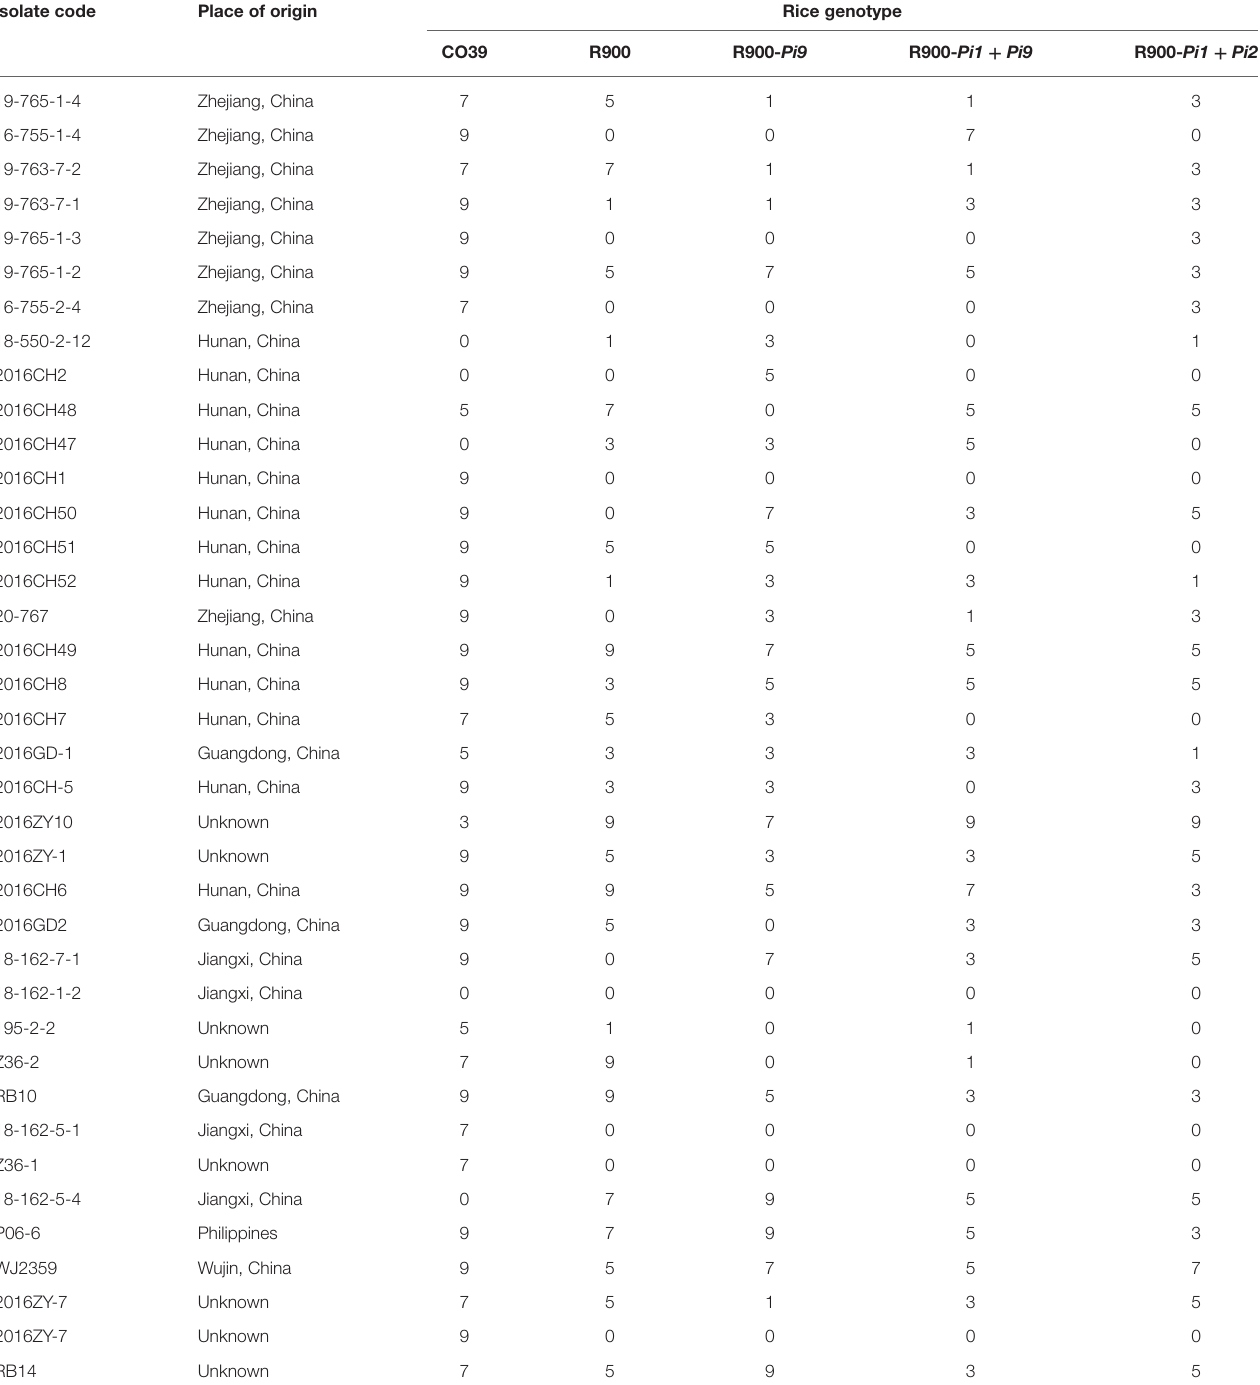
TABLE 2 | The detailed information of the M. Oryzae isolates and the disease reaction evaluated using a 0–9 rating system. Isolate